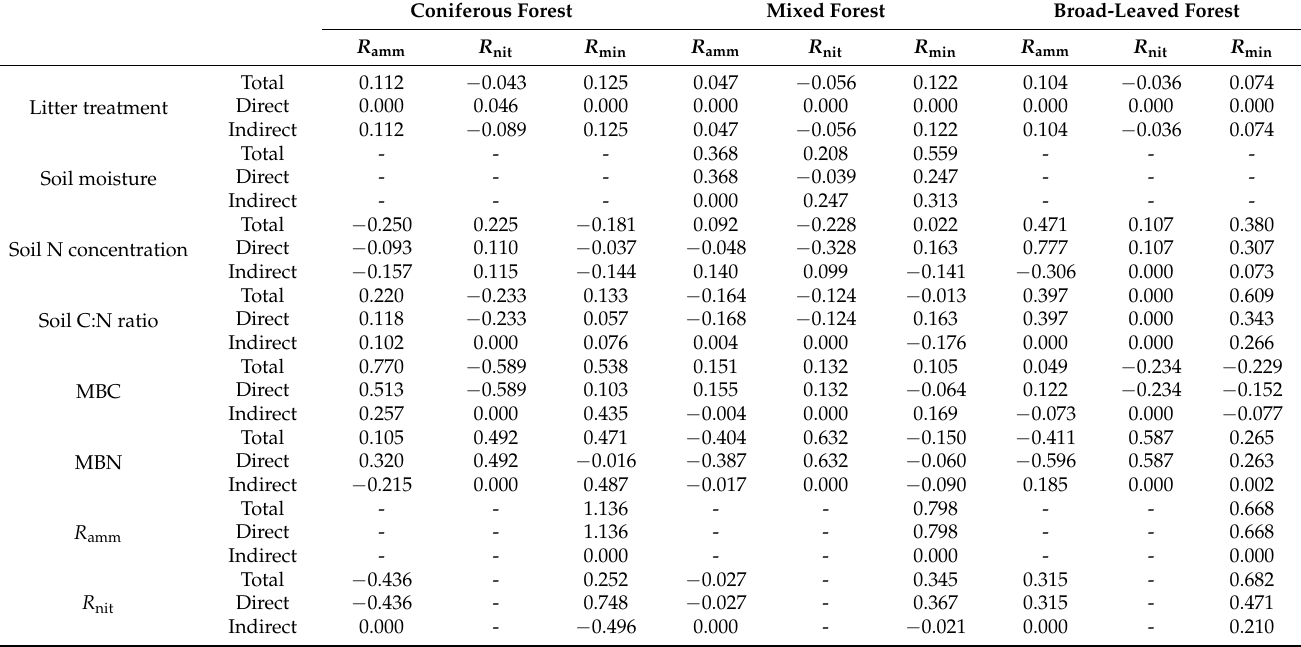
Table 2. Standardized total, direct, and indirect effects were estimated by the structural equation models (SEMs) to assess the effects of litter treatment, soil moisture, MBC, MBN, N concentration, and C:N ratio on the net soil ammonification ( R amm ), nitrification ( R nit ), and N mineralization ( R min ) rates in subalpine